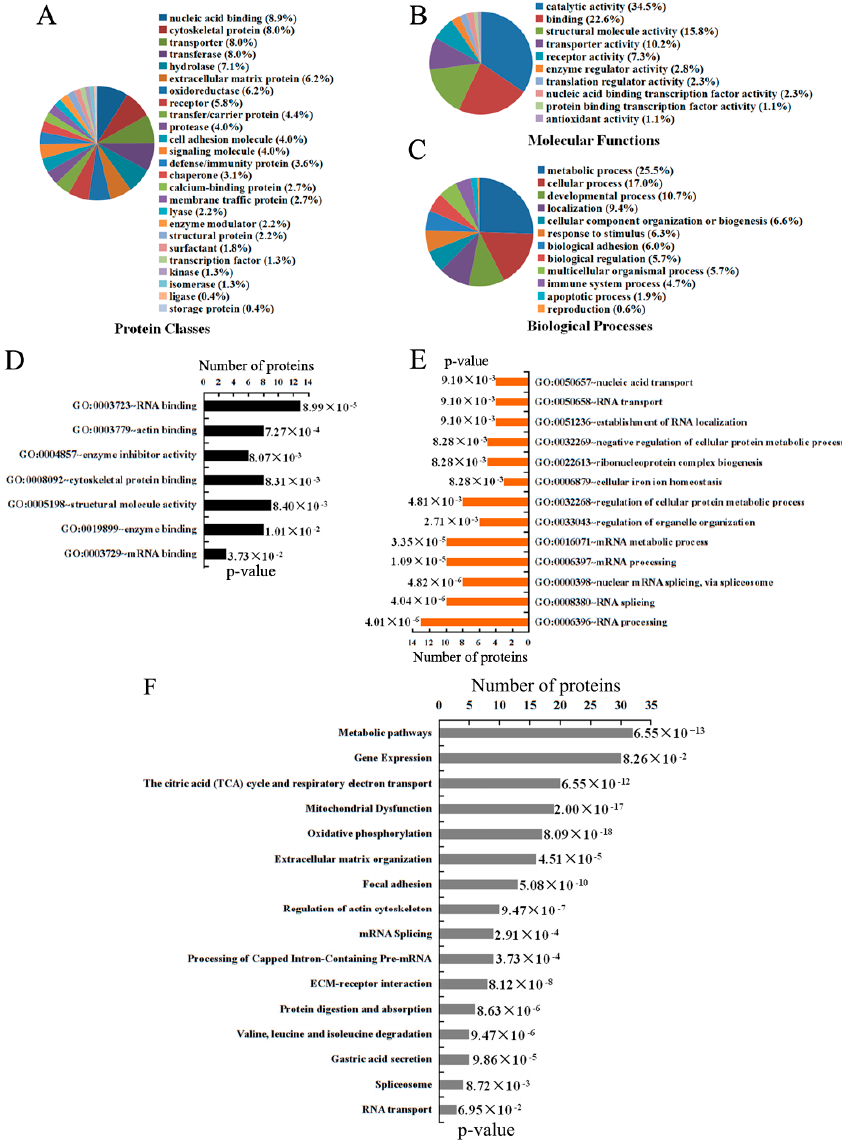
Figure 3. The functional annotation of dysregulated proteins was analyzed by Protein Analysis Through Evolutionary Relationships (PANTHER), Database for Annotation, Visualization and Integrated Discovery (DAVID), STRING and Reactome. ( A ) Protein Classes; ( B ) Biological Process; and ( C ) Molecular Function of 146 dysregulated proteins were summarized in a pie chart by PANTHER; ( D ) Molecular function; and ( E ) Biological process based on the 65 upregulated proteins were depicted in a bar graph by DAVID; ( F ) Pathway analysis of 146 dysregulated proteins was indicated by PANTHER, DAVID, STRING and Reactome. For each category, the percentage or p -value of dysregulated proteins is indicated.